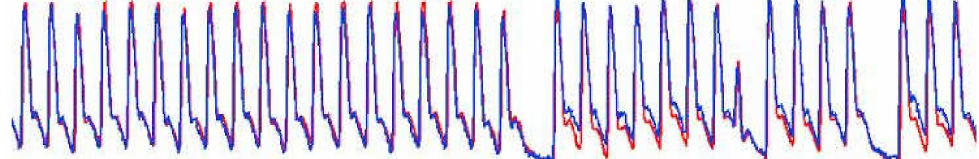
Figure 3. Comparison of normalized invasive arterial line data (red) taken simultaneously with normalized PyrAmes sensor data